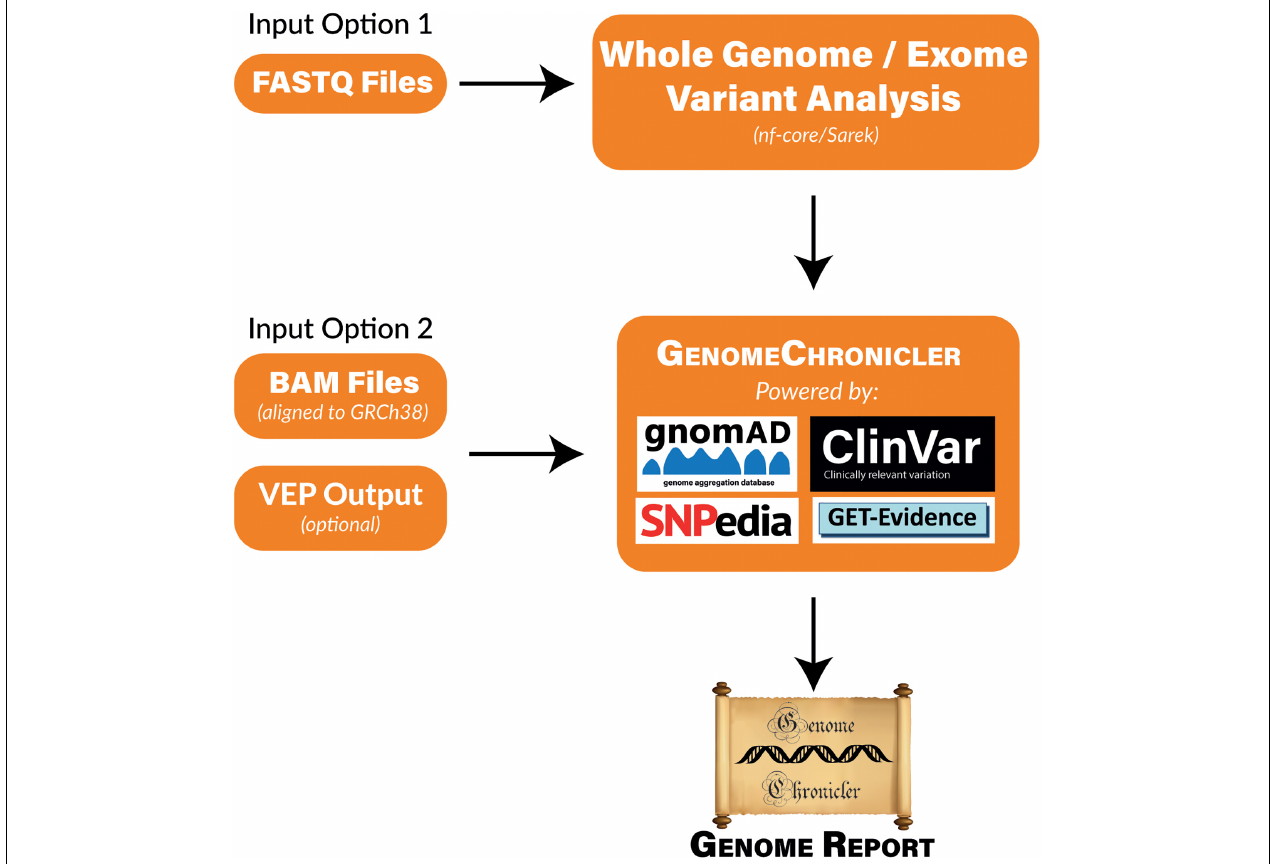
FIGURE 1 | Flow Diagram of GenomeChronicler processing pipeline, illustrating the multiple entry points for the pipeline, resources integrated by default and generated outcomes. Either entry point of the pipeline can be run locally in a single machine, as a Nextflow workflow or in the Cloud. All source code and integrations are freely available in their respective GitHub repositories. The stand-alone GenomeChronicler is available at (https://github.com/PGP-UK/GenomeChronicler), the integration of GenomeChronicler with Nextflow is available at (https://github.com/PGP-UK/GenomeChronicler-nf) and the combined GenomeChronicler with Sarek variant calling is available at (https://github.com/PGP-UK/GenomeChronicler-Sarek-nf). The recipe files for the Docker and Singularity containers are available within the respective GitHub repositories. The resource logos are reproduced from the respective resource websites and remain copyright of their original